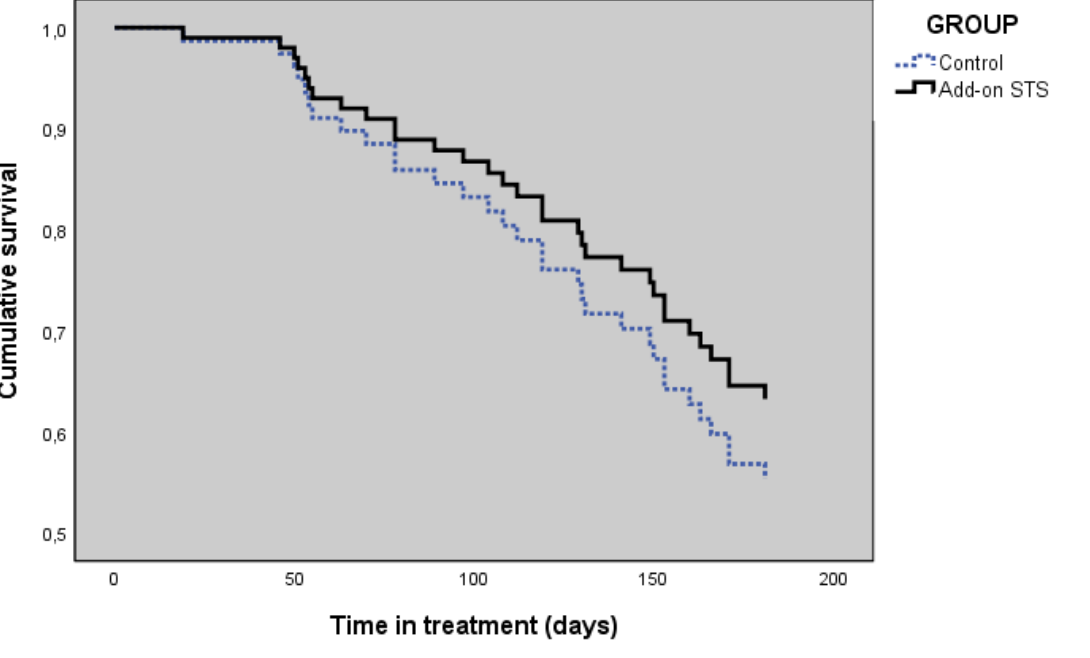
Figure 2. Cox regression survival curves for staying in treatment for the add-on STS and control groups at 6 months. STS: scheduled telephone support.